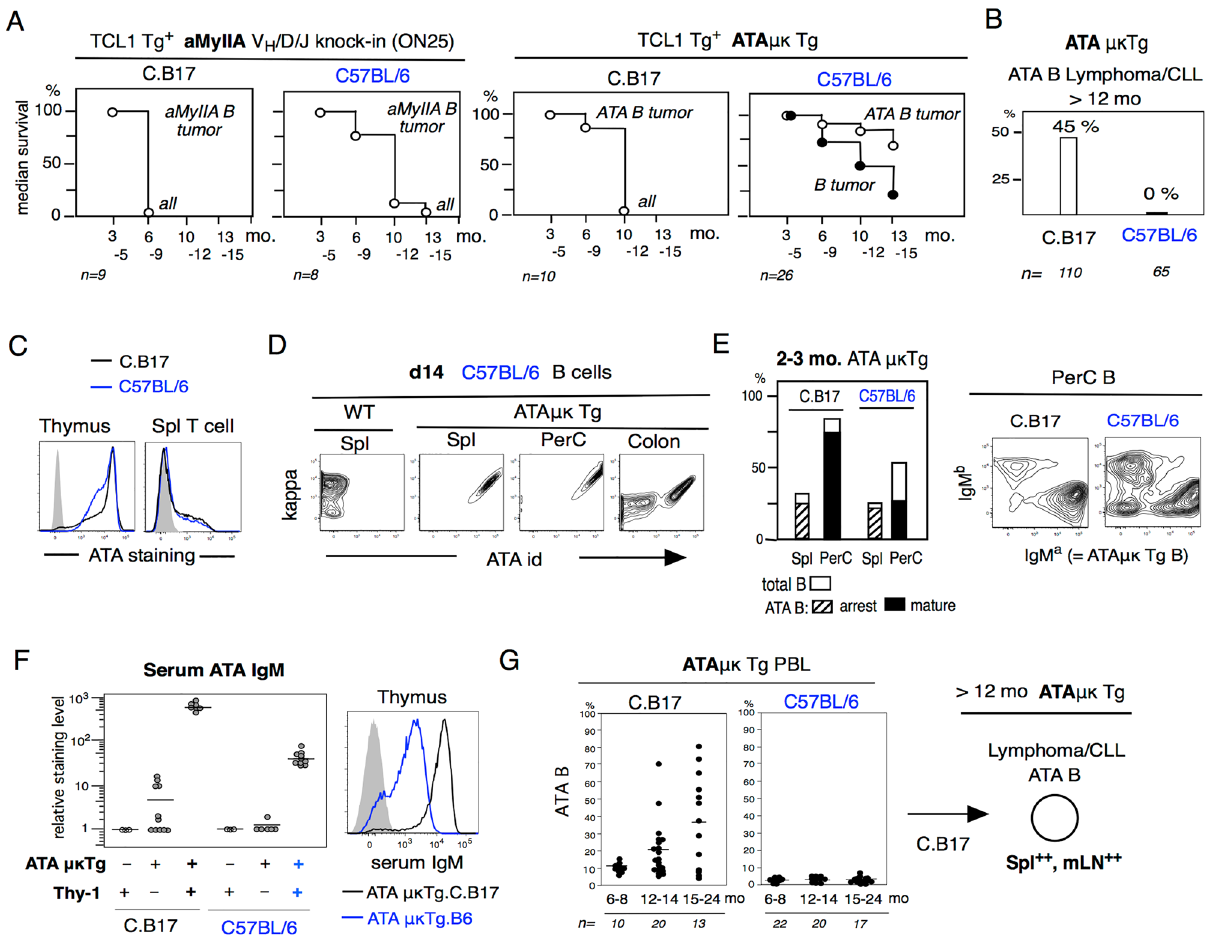
Figure 1. Low and negative B-1 derived lymphoma/CLL generation in C57BL/6 mice.B-1 derived aMyIIA B cells in aMyIIA KI mice and ATA B cells in ATAμκ Tg mice in C.B17 and C57BL/6 backgrounds. ( A ) CLL/ lymphoma in aMyIIA KI and ATAμκTg mice crossed with Eμ-hTCL1 Tg mice for the aMyIIA B and ATA B tumor generation stages. ( B ) Spontaneous (TCL1Tg – ) ATA B lymphoma/CLL generation in > 12 mo mice in the C.B17 background versus negative in C57BL/6 mice. ( C ) ATA IgM (IgM a+ ) staining of T cells in C.B17 and C57BL/6 mice. ( D ) Early generation of ATA B cells in d14 ATAμκTg mice. C57BL/6 mice. ( E ) In the 2–3 mo adult stage, there were fewer total B cells and ATA B cells in the PerC of C57BL/6 mice than in C.B17 mice. In the PerC, the number of non-ATA B cells with endogenous IgM b+ B cells was increased in C57BL/6 mice. ( F ) Serum ATA IgM in 2–3 mo C.B17 and C57BL/6 mice crossed with ATAμκTg or ATAμκTg with Thy-1 – , and ATAμκTg – wild type. Serum ATA IgM from ATAμκTg mice stained with C.B17 thymus. ( G ) Serum ATA B cells in PBLs from the 6 mo to 24 mo stage in C.B17 and C57BL/6 ATAμκTg mice. > 12 mo, generation of ATA B lymphoma (Spl ++ , mLN ++ ) in ATAμκTg.C.B17 mice as previously reported 10